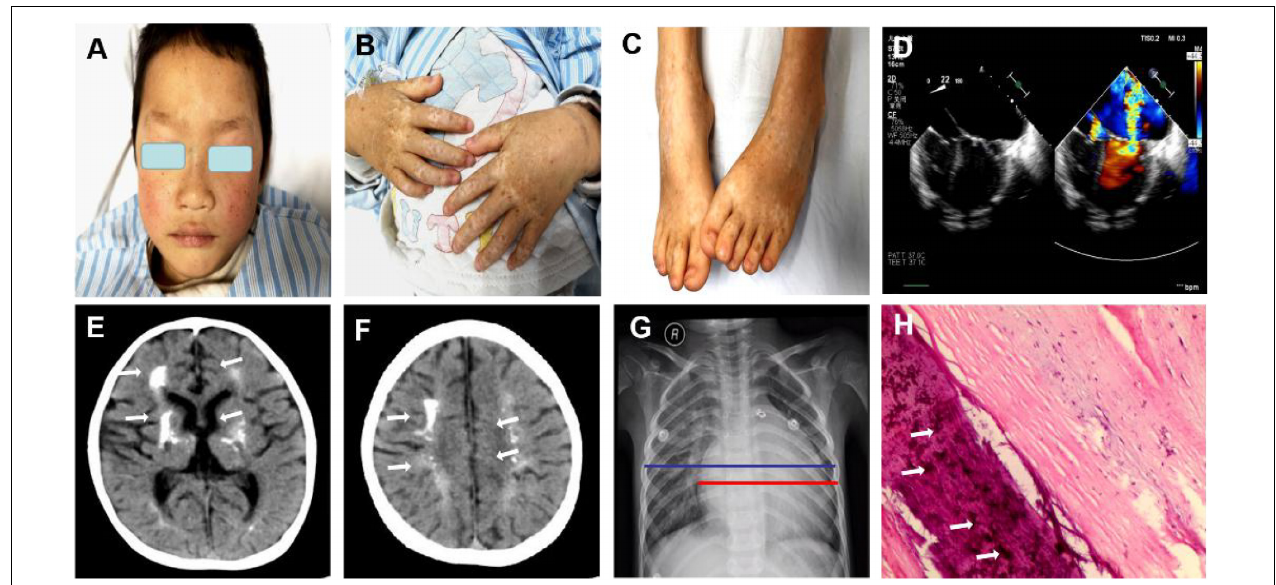
FIGURE 1 | Clinical features of the patient with both dyschromatosis symmetrica hereditaria (DSH) and Aicardi-Goutières syndrome type 6 (AGS 6). The symmetrical appearance of freckle-like pigmentation and hypopigmentation spots were on the face (A) , backs of hands and feet (B,C) , presenting a reticulate pattern. Enlarged cardiac shadow was observed through Chest radiographs, and the cardio-thoracic ratio was around 0.65. (D) Cardiac color ultrasound showed normal postoperative cardiac changes after patent ductus arteriosus closure, severe mitral regurgitation (MR) and moderate mitral stenosis (MS), extremely mild aortic regurgitation (AR), mild + tricuspid regurgitation (TR) and a small amount of pericardial effusion (PE). (E,F) Brain computed tomography revealed calcification in the dentate nucleus, basal ganglia and cerebral white matter and mild brain atrophy. The textures of both lungs were increased and blurred, and there were small patchy shadows (G) . (H) A mitral valve biopsy revealed significant valve calcification, and the arrows marked the